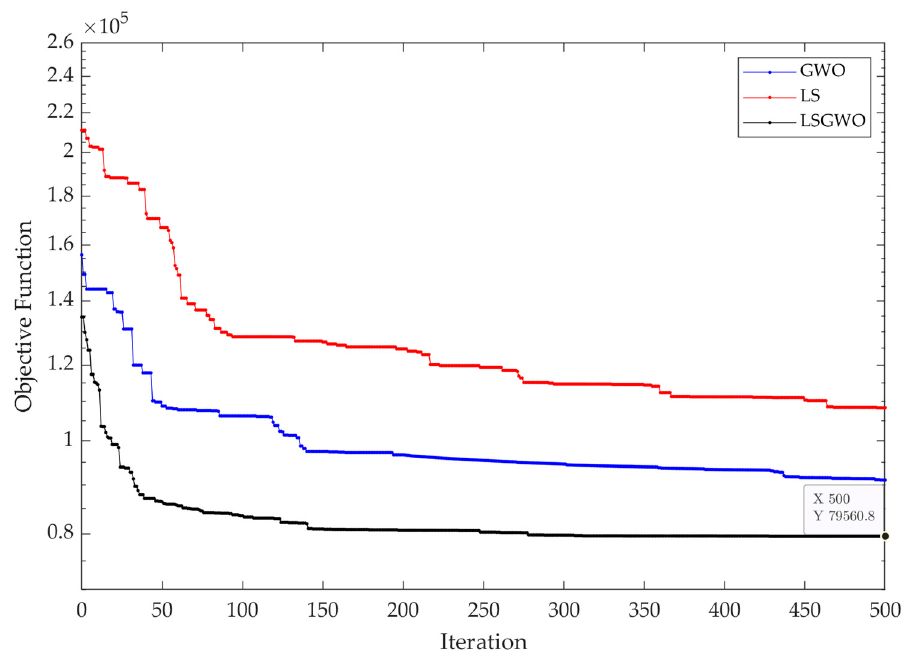
16 of 21 Table 3. Parameters of the BPSCN model. Parameter